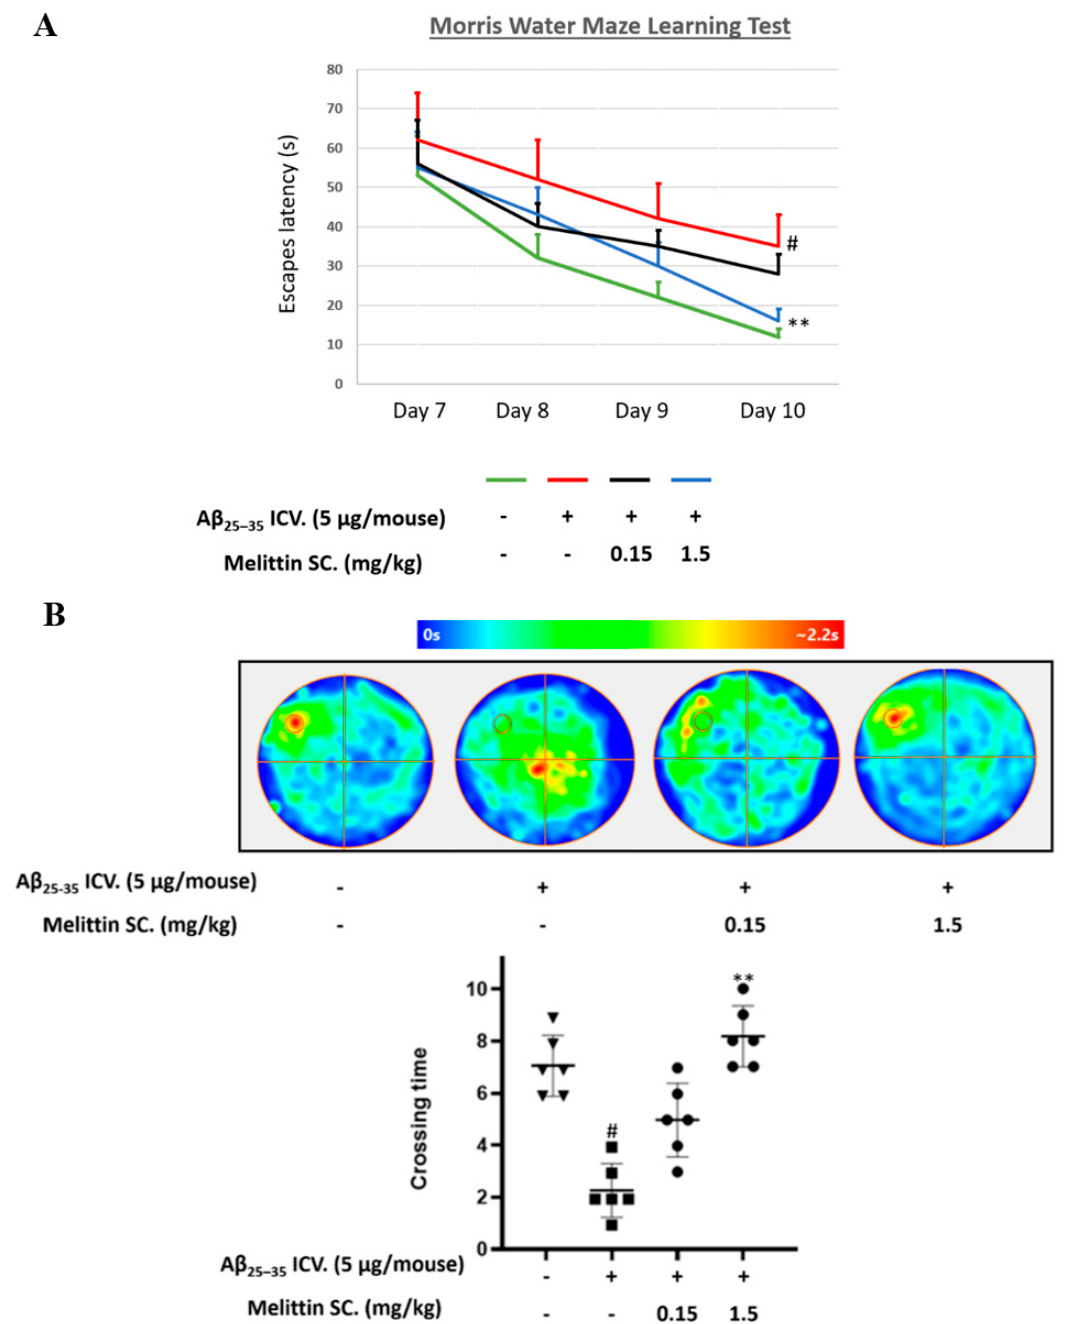
Figure 6. Protective effect of melittin on memory in A β 25–35 -treated mice studied in a Morris water maze experiment. Two tests ( A , B ) exhibited a decrease in learning and memory performance when mice were induced with A β 25–35 ICV., and melittin 1.5 mg/kg significantly reversed this cognitive disfunction effect. The water maze behavior experiment recorded the escape latency time on days 7–10. ( A ) Animal escape latency performance on days 7 to 10. To conduct this